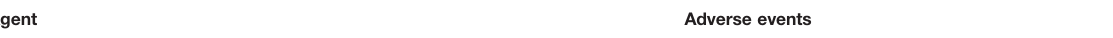
TABLE 3 | Summary of adverse events in immune checkpoint